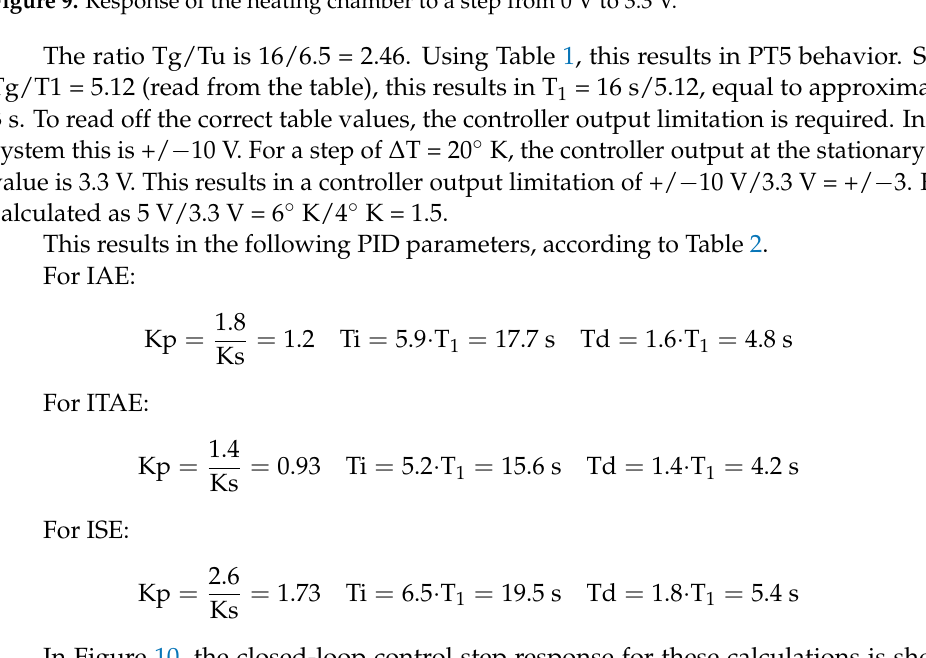
Figure 9. Response of the heating chamber to a step from 0 V to 3.3 V.